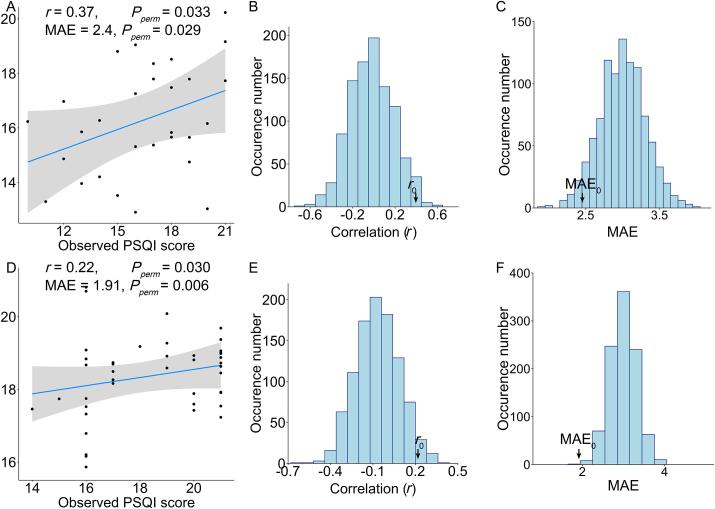
Whole-brain patterns of regional functional connectivity strength significantly predict an unseen individual’s sleep quality in both short-term/acute and chronic insomnia. (A) Scatter plot of the correlation between the observed and predicted PSQI scores across all patients with short-term/acute insomnia. The permutation distribution (1,000 times) suggests that both (B) the correlation r and (C) the mean absolute error (MAE) between the observed and predicted PSQI scores were significantly better than those acquired by chance in the short-term/acute insomnia group. Similarly, (D) for patients with chronic insomnia, both (E) the correlation r and (F) MAE between the observed and predicted PSQI scores are significantly better than those acquired by chance.